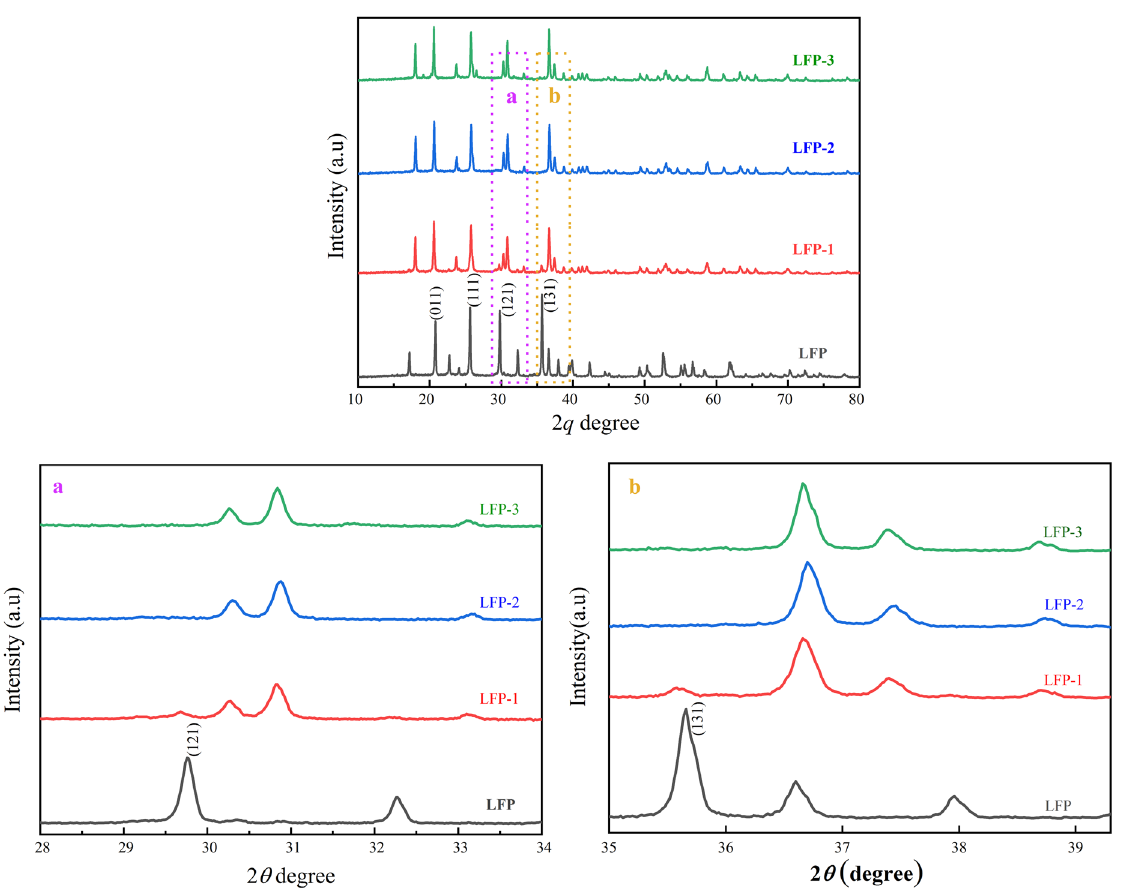
Figure 2: XRD patterns for di ff erent NaClO, and the outlined sections A and B of complete patterns correspond to Figure 2a and